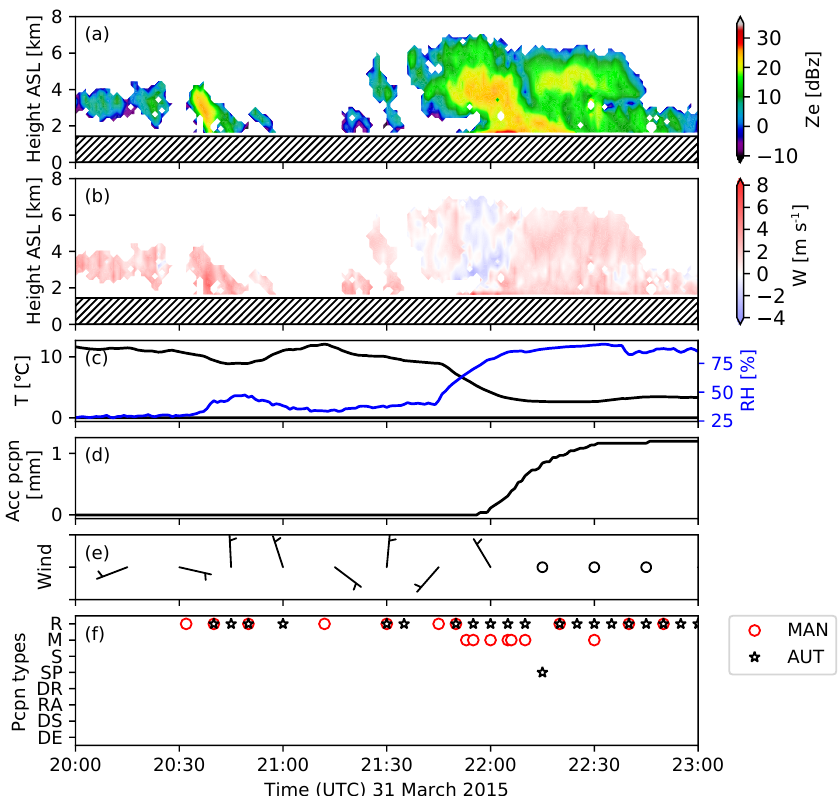
Figure 5. Time evolution (UTC) on 31 March 2015 of (a) reflectivity and (b) vertical particle motion fields retrieved from the Micro Rain Radar 2 (MRR2) for the westerly flow field event. Positive Doppler velocities indicate downwards motion. (c) is the surface temperature ( T ) and relative humidity (RH), (d) is the unadjusted accumulated precipitation at the surface at KES, (e) is the wind speeds and direction represented by the wind barbs, and (f) is the manual observation of precipitation types (MAN) as well as diagnosed using the OTT Par- sivel (AUTO) following Ishizaka et al. (2013). The hatched region on the MRR time series (a, b) indicates ground-level height. The MRR2 quality control was based on Maahn and Kollias (2012). See Appendix A for details on the precipitation type diagnostic method. Note that a wind barb is like an arrow on which the barb is the wind speed (short line is 5 knots and the long line is 10 knots). It points in the direction to which the wind is